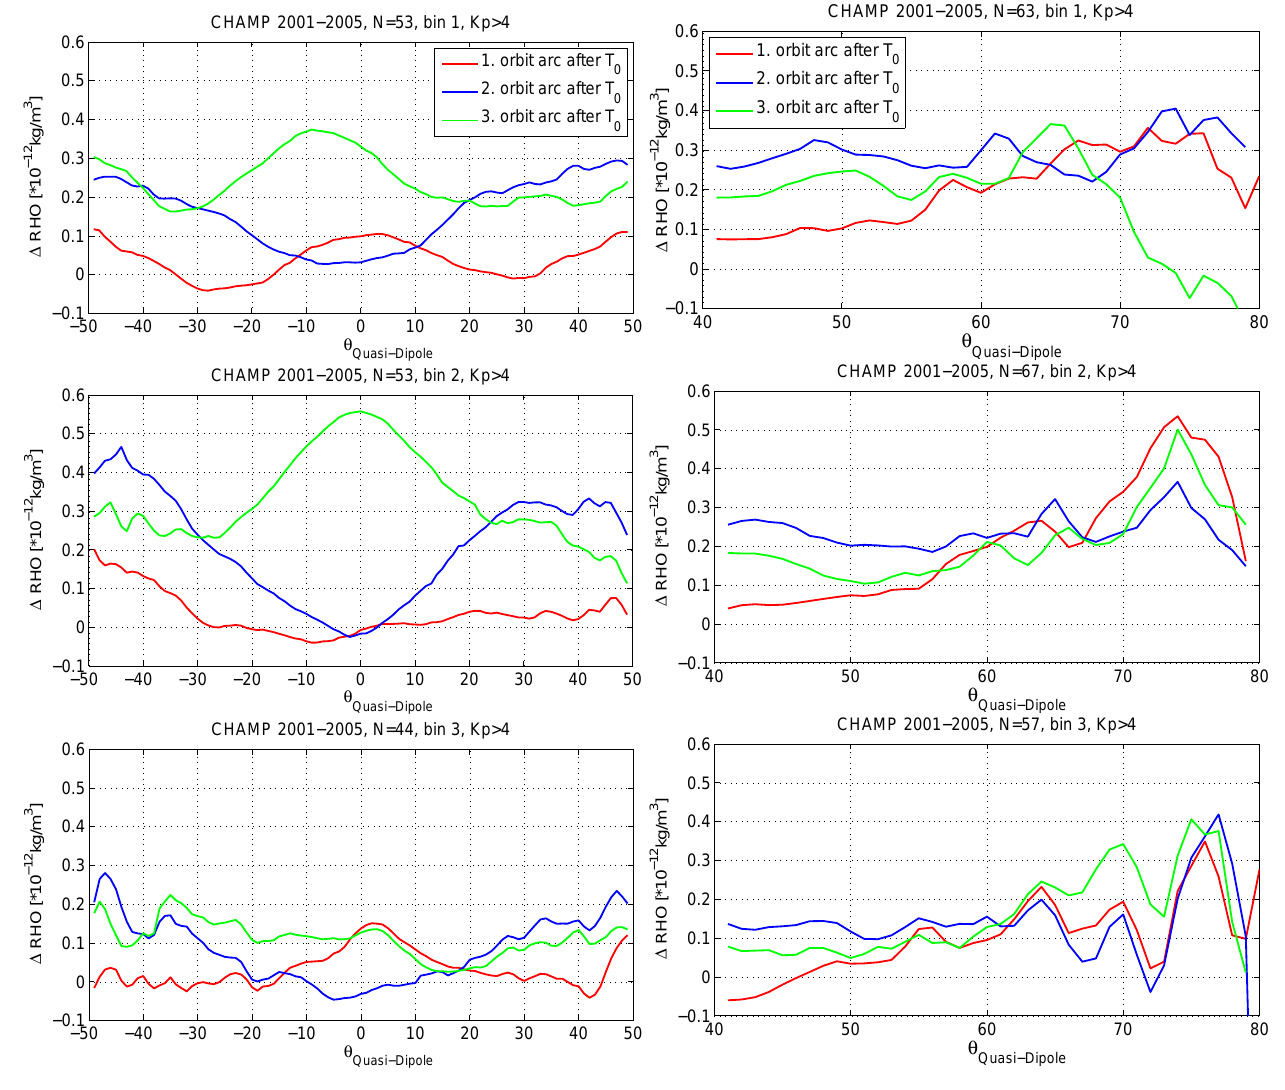
Fig. 5. Differences of thermospheric density, data before a substorm onset are subtracted from data after T 0 , at low (left column) and high (right column) latitudes for Kp > 4. Frames from top to bottom contain subsets of bins 1,2,3 with calculated mean MLT 22.5h, 24.0h, 1.0h, respectively. Red line: 0.25–1.25h after substorm onset T 0 ; blue line: 1.75–2.75h after T 0 ; green line: 3.25–4.25h after T 0 . The mean uncertainty of the density curves is ± 0 . 1 × 10 − 12 kg/m 3